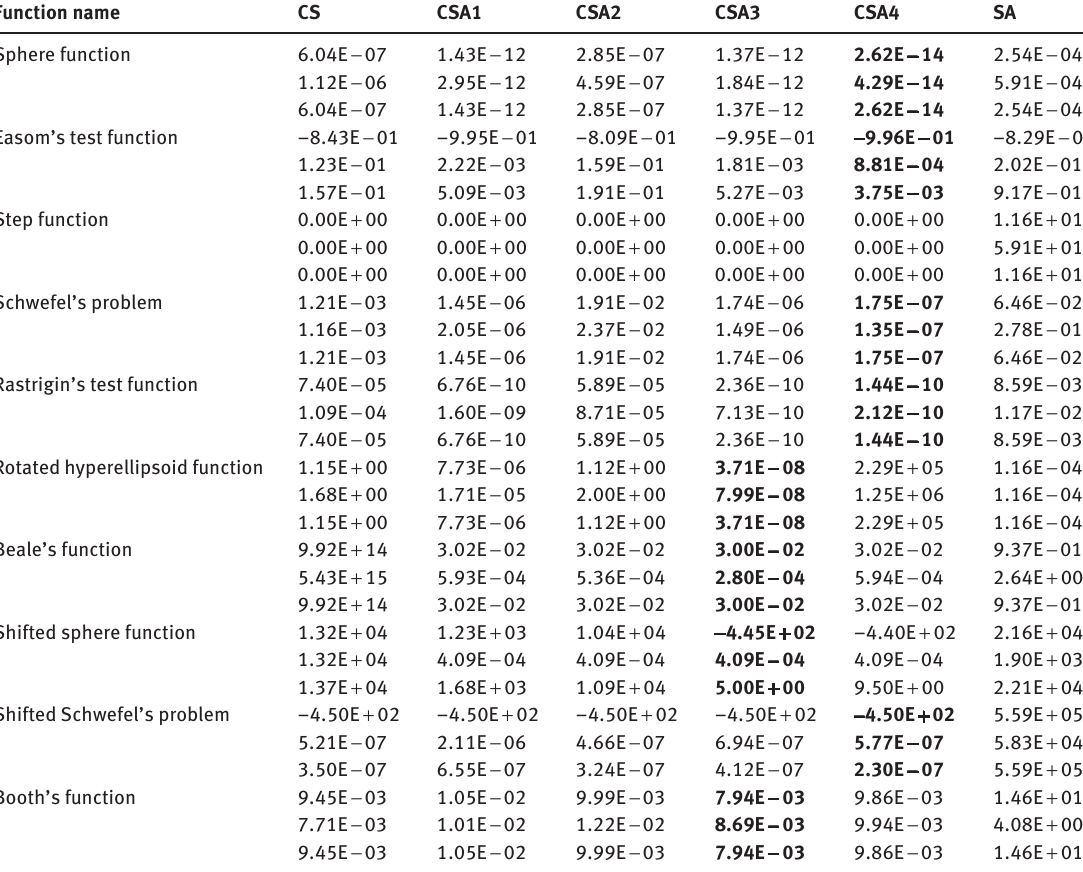
Table 2: Experimental Results of the Algorithms for each of the 10 Benchmark Functions. Function name